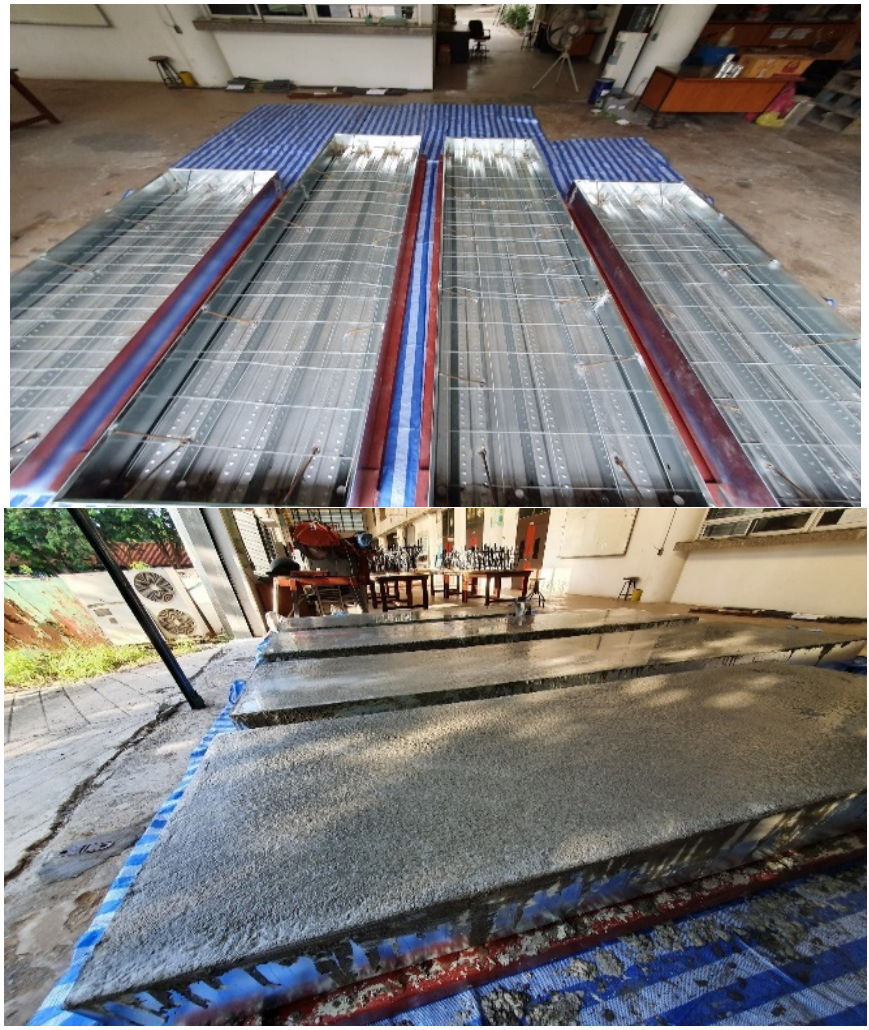
Figure 2. Casting of specimens. Table 1. Dimensions and shear span-to-depth ratio of composite decks. Table 1. Dimensions and shear span-to-depth ratio of composite